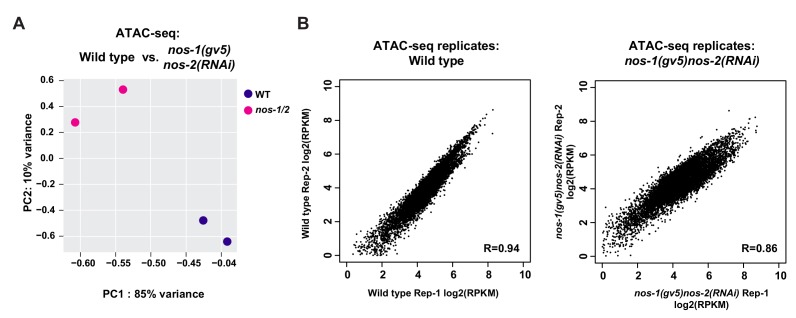
Analysis of reproducibility between ATAC-seq samples.(A) PCA of ATAC-seq peaks between replicates. (B) Scatter plots comparing the ATAC-Seq peak scores (RPKM) between replicates. RPKM values for each replicate were obtained from DiffBind analysis. The Pearson correlation of the RPKM values are shown. Detail description of correlation analysis is listed in Materials and methods section.